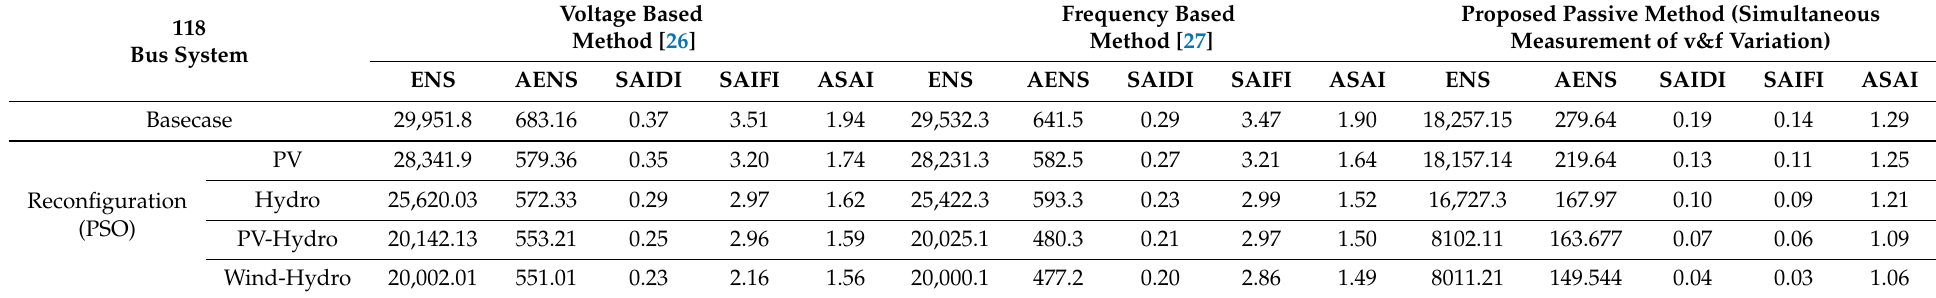
Table 8. Comparison results of reliability evaluation for the 118 bus